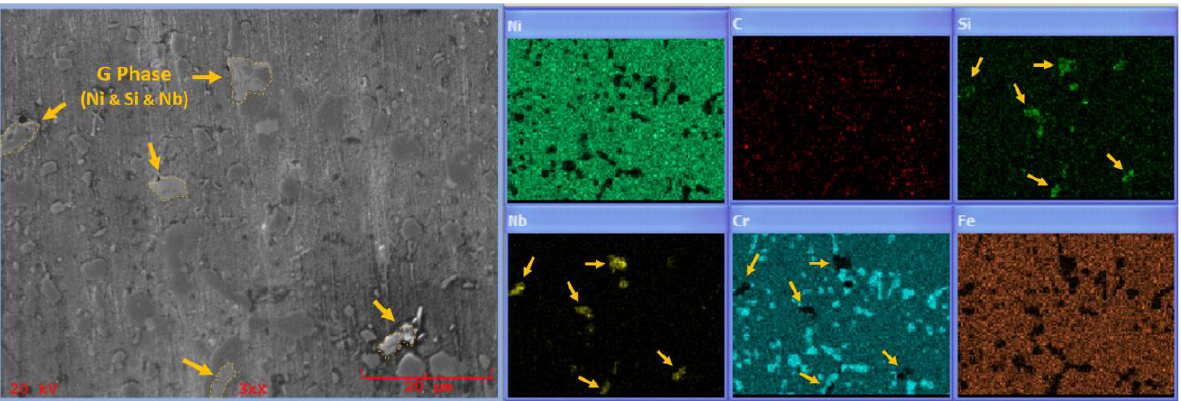
Figure 4. X-Ray Mapping images of tube A showing the distribution of various elements in SEM images.